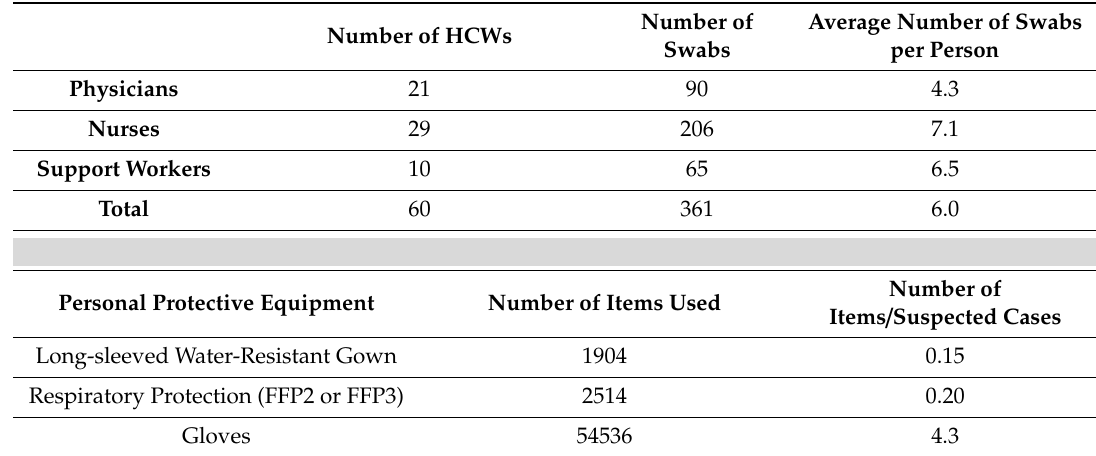
Table 2. Nasopharyngeal swabs performed on the healthcare workers and personal protective equipment used during the 8 weeks study period.